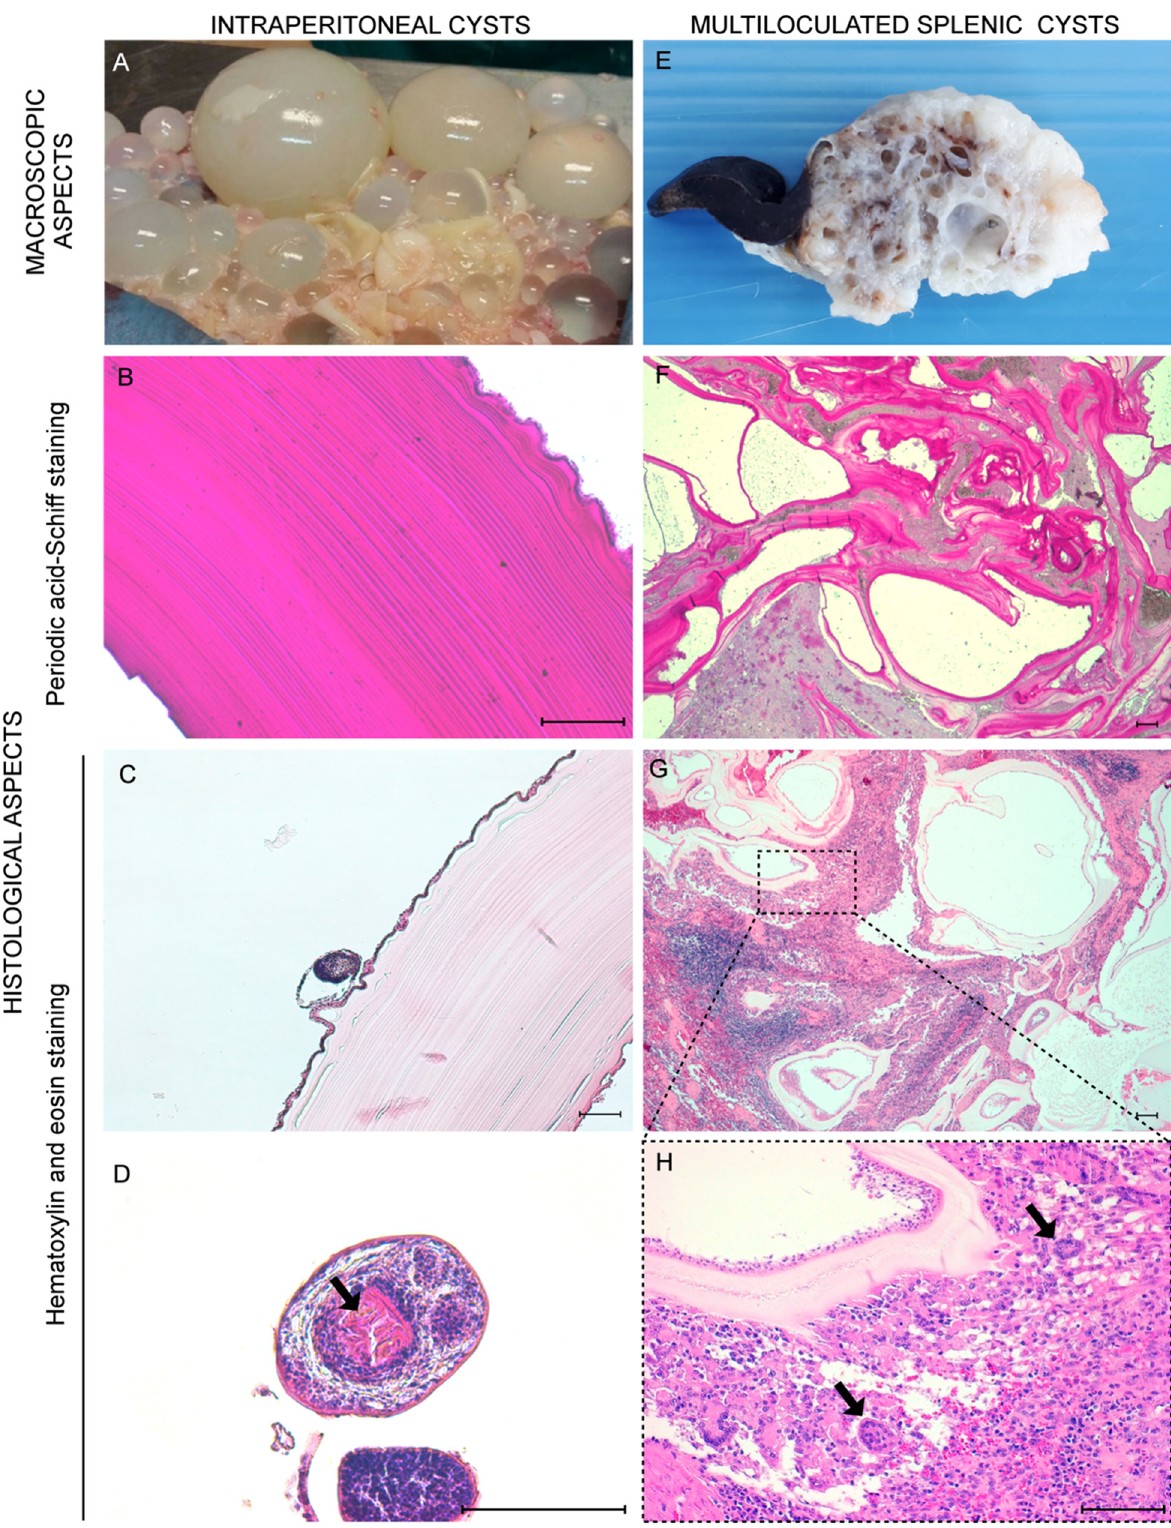
Figure 2. Gross and histopathological features of hydatid cysts. Free peritoneal hydatids of different dimensions extracted following laparotomy (A). Peritoneal hydatid tested by period-acid-Schiff (PAS) stain (B). Peritoneal hydatid with laminated layer and a brood capsule budding from the germinal layer (C). Protoscoleces in hydatid cavity. Notice the chain of hooks (arrows) (D). Portion of the spleen occupied by multiple cysts (E). Spleen cysts tested by period-acid-Schiff (PAS) stain (F). Spleen cysts displaying laminated, germinal and adventitial layers with in fl ammatory and fi brotic reaction (G); Greater magni fi cation of the micrograph G showing the epithelioid rim around the cyst wall, giant cells (arrow) (H). Hematoxylin and eosin staining (H&E). Scale bars 100 m